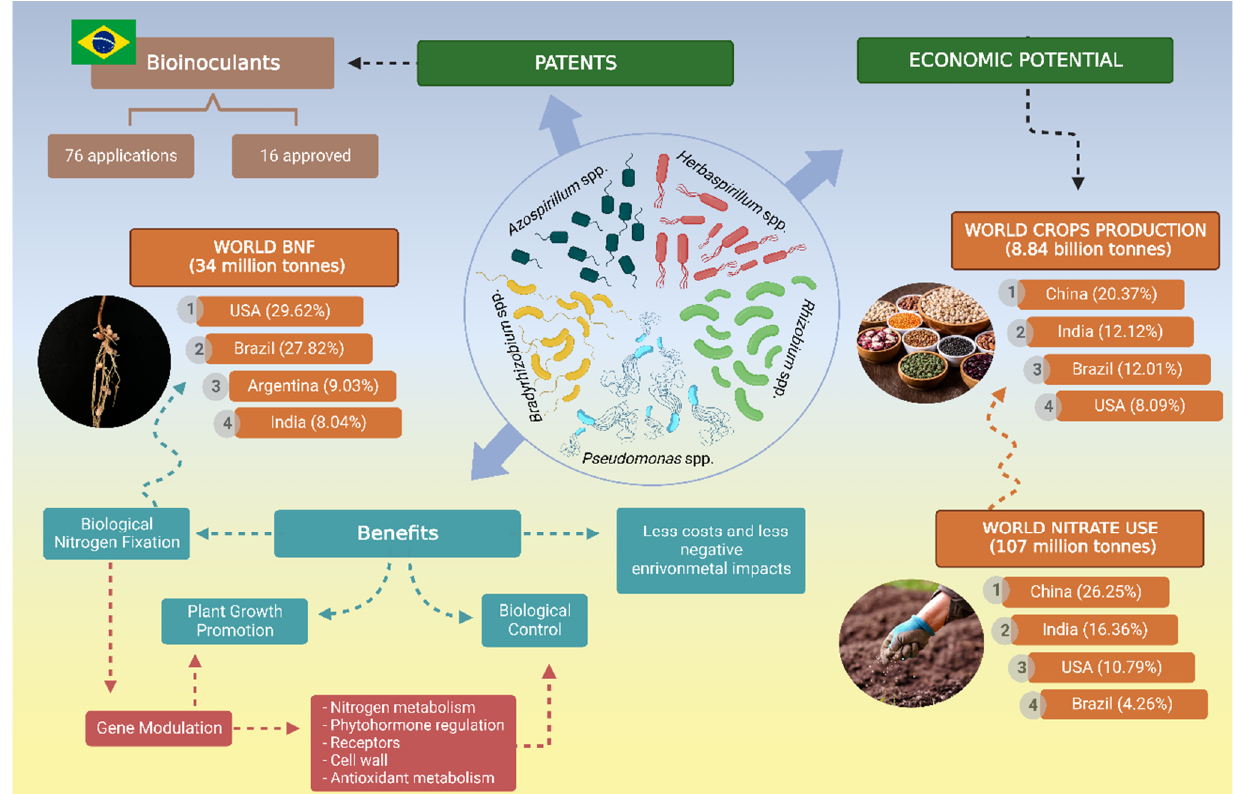
Figure 1. The impact of diazotrophic bacteria for more sustainable agriculture practices. Diazotrophic bacteria can bring great benefits to plants, including biological nitrogen fixation, plant growth promotion, tolerance to stresses, and biological control, as well as positive economic and environmental impacts. The mechanisms involve modulation of plant gene expression in key metabolic and physiological pathways. The use of bioinoculants can contribute to more sustainable agriculture, including economic potential, by reducing the costs associated with the use of nitrogen fertilizers. Brazil is one of the countries that is leading biotechnological research in the area of bioinoculants, represented by the growing number of patent applications for formulations of bioinoculants. Created with BioRender.com accessed on 31 August 2022.